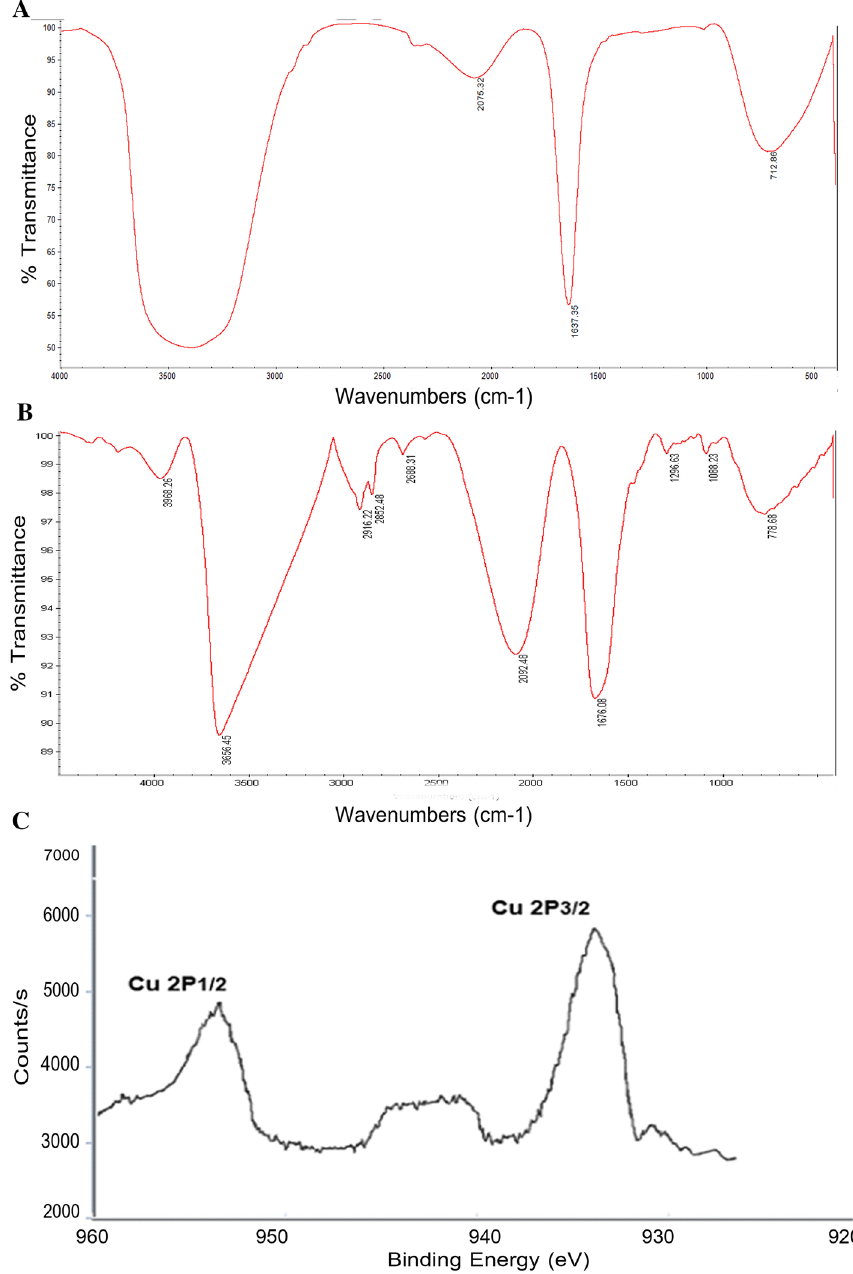
Figure 4. FT-IR spectrum of ( A ) the supernatant of B. coagulans , ( B ) BC-CuONPs, ( C ) XPS analysis of of B. coagulans . The peak 2092 cm −1 belongs to the N=C=S group. The peak 1637 cm −1 might belong to the C=C bond outside the aromatic ring or the tensile vibrations of the C=O carbonyl bond in the nucleic acid of the cell nucleus. Due to their multiplicity, the peaks associated with the bending vibrations of C–H bonds of alkene and aromatic groups (C=C–H) were observed wildly around the absorption frequency of 712 cm −1 . In the FTIR spectrum of reduced CuONPs with bacterial supernatant biomolecules, the peak in the region of 3100–3680 cm −1 is attributed to the amide or amine functional group in the bacterial protein membrane or O–H group in Cu(OH) 2 due to the N–H bond tension. Both 2916 cm −1 and 2852 cm −1 peaks belong to the aliphatic C–H bond. The peak 2092 cm −1 is related to the N=C=S group. The peak 1676 cm −4 might belong to the C=C bond out of the aromatic ring or the C=O bond in the nucleic acid of the cell nucleus. The peak 1088 cm −1 is associated with the C=O bond in a carboxylic acid. Peak 1296 cm −1 is also related to the bending vibration of the C–O–H or C–O ester group in lipids. The FTIR outcomes that verified the existence of the bioactive substances